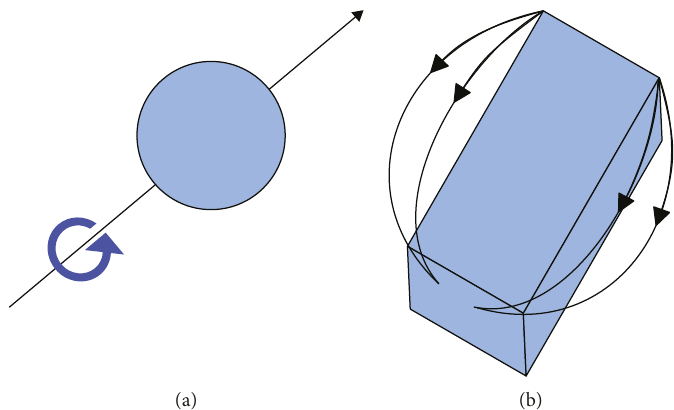
Figure 1: Photon spin moment and its equivalent. (a) Photon spin moment. (b) Equivalent bar magnetic moment.